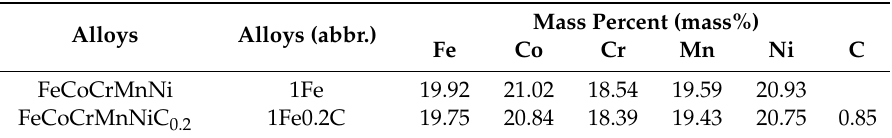
Table 1. Alloy composition (mass %) and aberrations in FeCoCrMnNi high entropy alloys (HEAs) and FeCoCrMnNiC x HE cast iron alloys [23].